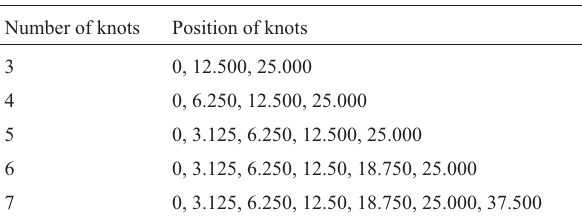
Table 2 - Position of knots at inbreeding levels (%F) for the five cu- bic-spline models. Number of